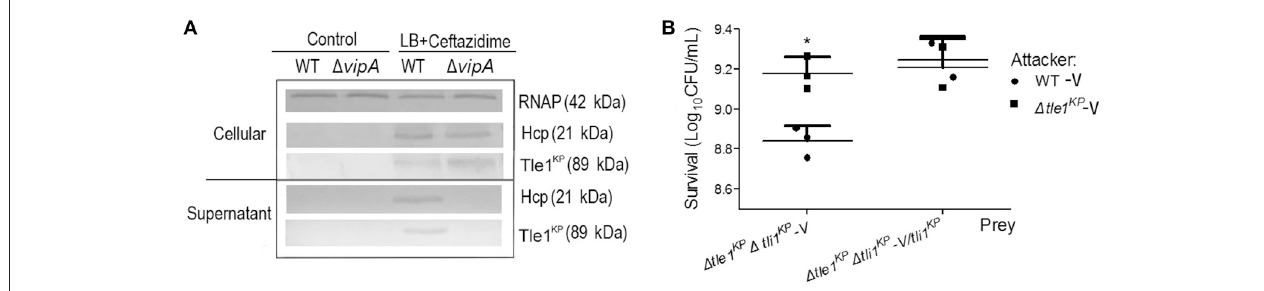
FIGURE 3 | The identification of effector and immune protein pair. (A) Immunoblots in the supernatant and cellular fractions of the HS11286 wild-type and 1 vipA mutant using specific antibodies against Tle1 KP , Hcp, and RNAP (cellular control). Samples acquired in liquid culture with 32 mg/L ceftazidime (Supplementary Figure 8). The westernblot membranes were cropped from the original images available at the Supplementary Figure 10. (B) Bacterial competition assays. Deletion mutant strain ( 1 tle1 KP 1 tli1 KP - V) and complementation of 1 tle1 KP 1 tli1 KP mutant with tli1 KP ( 1 tle1 KP 1 tli1 KP -V/ tli1 KP ) as the prey strains following co-culture with the attacking strains (the WT-V and 1 tle1 KP -V mutant, Supplementary Table 1). All strains carried the vector control plasmid pBAD33-Apra. Each group has three replications. * P < 0.05.